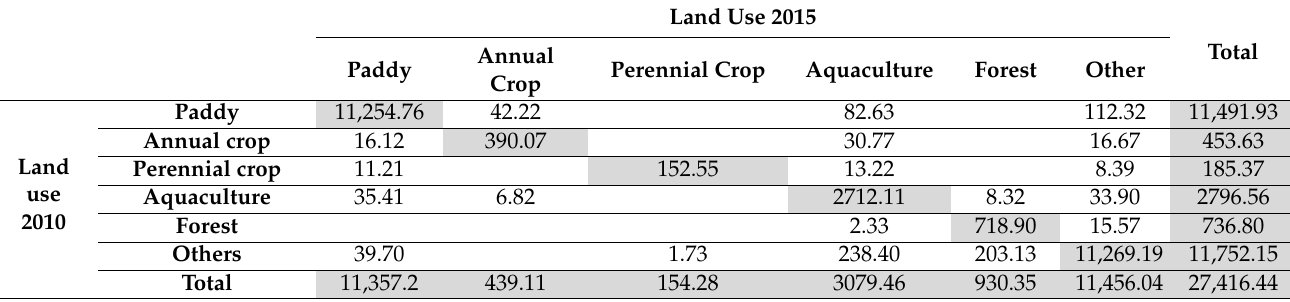
Table 6. Land-use change matrix between 2010 and